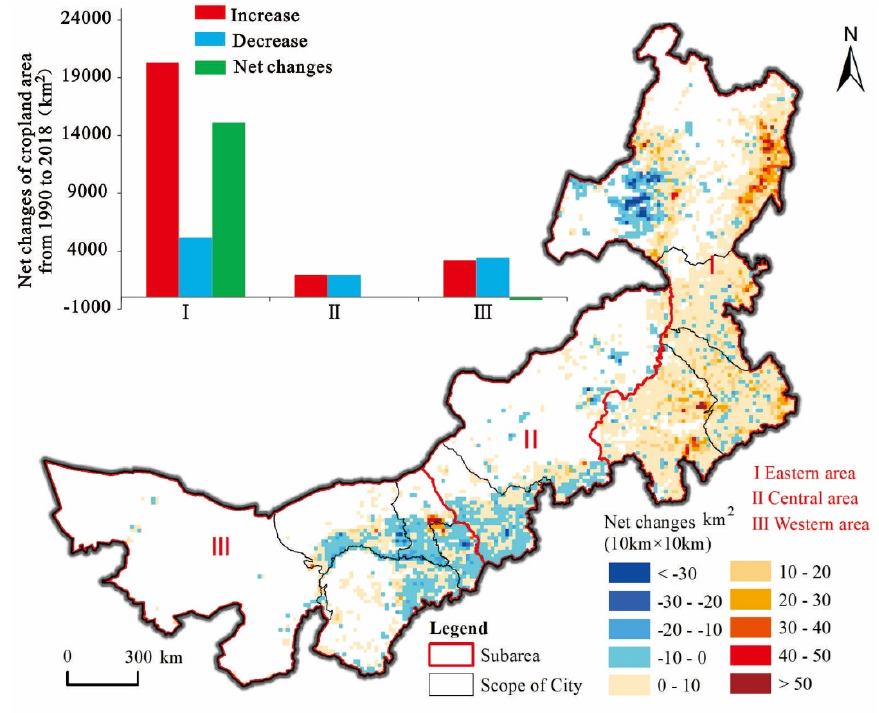
Figure 3. Spatial pattern of cropland evolution in Inner Mongolia of China from 1990 to 2018. Table 1. Cropland changes in different sub-regions during different periods.